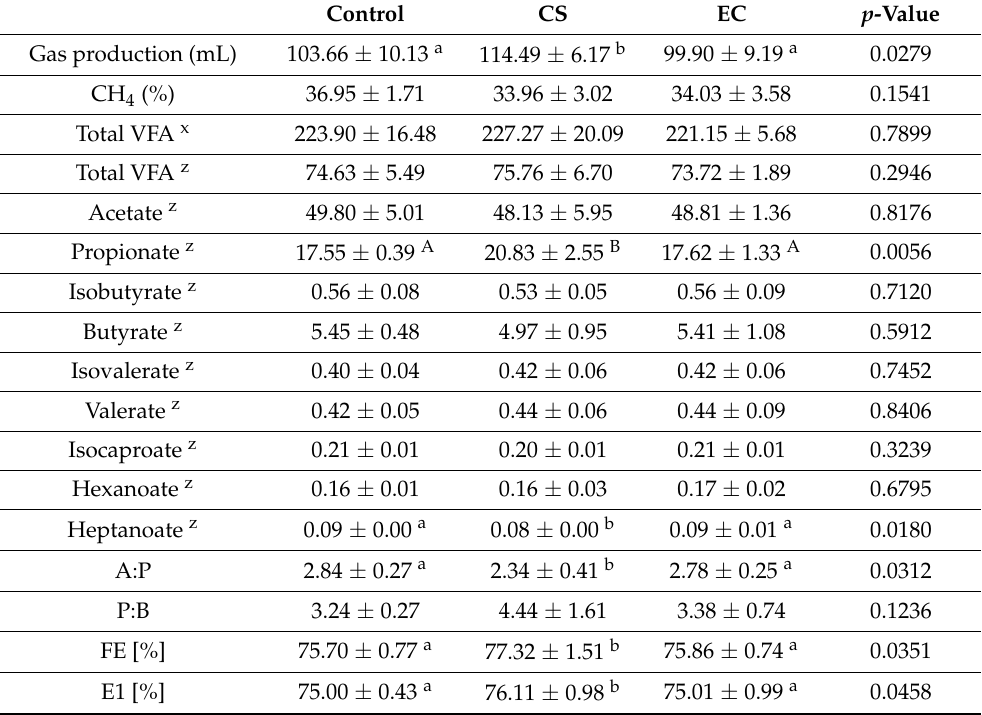
Table 3. Effects of copper sulfate (CS) and encapsulated copper (EC) addition on fermentation profile ( in vitro